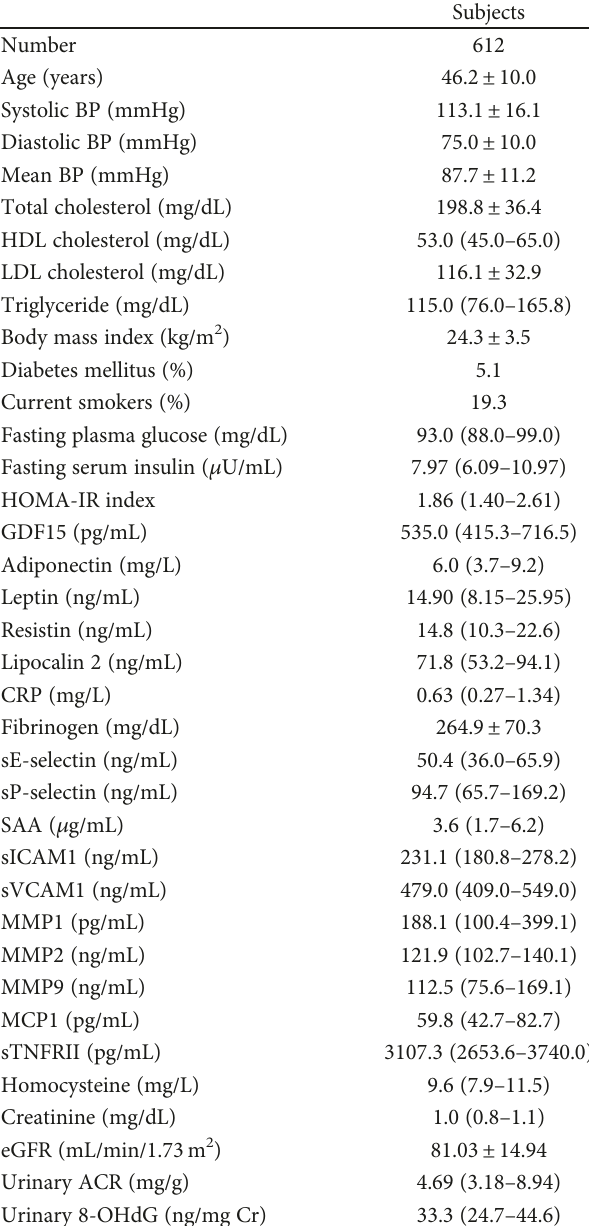
Table 1: Baseline characteristics of the study subjects from the healthy